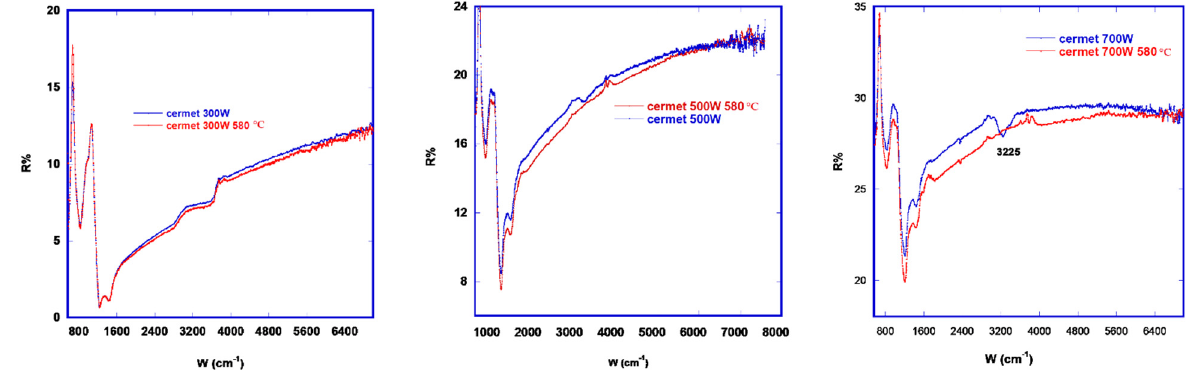
Figure 11. FTIR reflectance of cermet AlN–WN produced at 300 W, 500 W and 700 W.